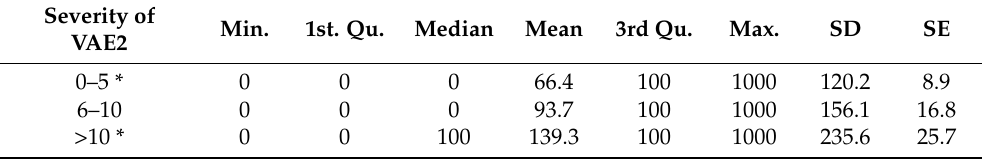
Table 5. The relationship between the presence of VAE2 and ANA T1 titres. Severity of Min. 1st. VAE2